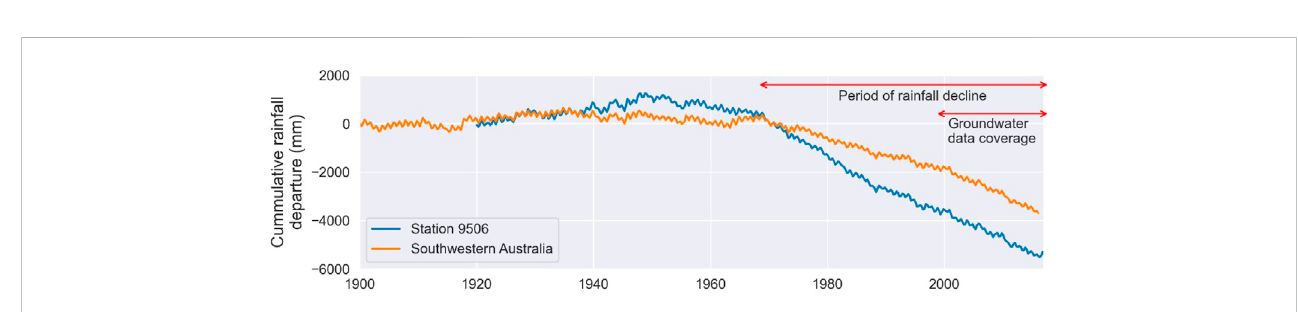
FIGURE 2 Location of study site, Lake Muir and nearby surface water